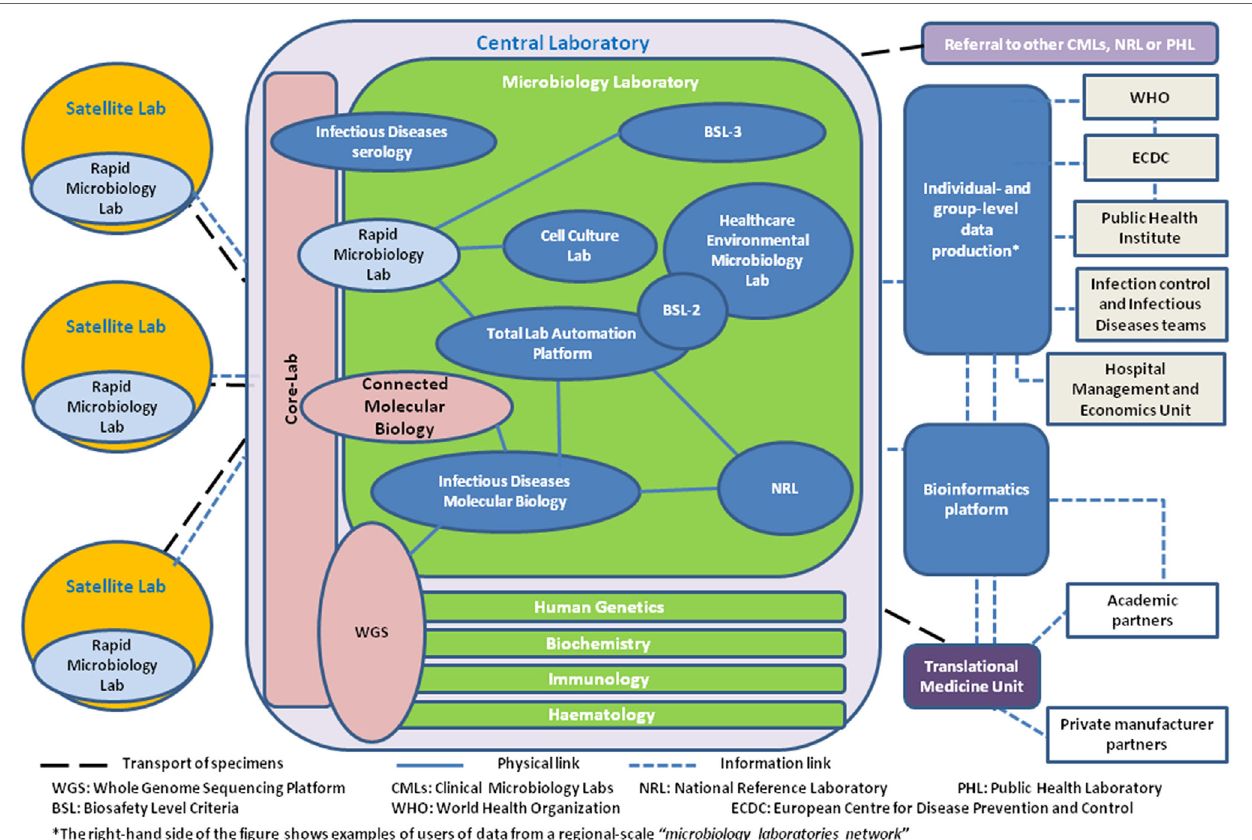
FiGUre 1 | Bubble diagram describing the relationships between the different laboratory, public health, and translational medicine structures in a clinical microbiology network